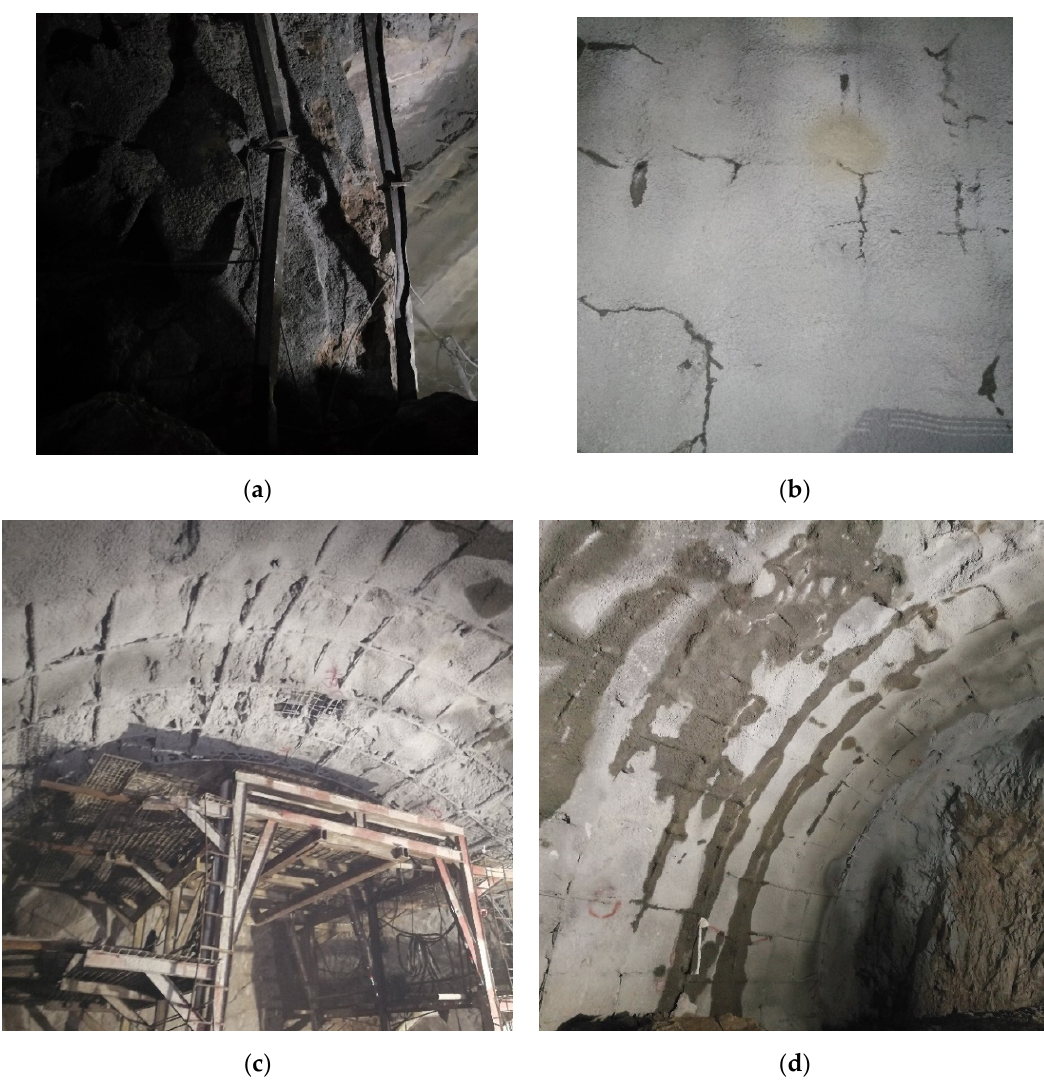
Figure 5. Tunnel damages in the experimental section: ( a ) Steel frame distortion; ( b ) Shotcrete crack; ( c ) Small scale tunnel collapse; ( d ) Primary lining leakage.